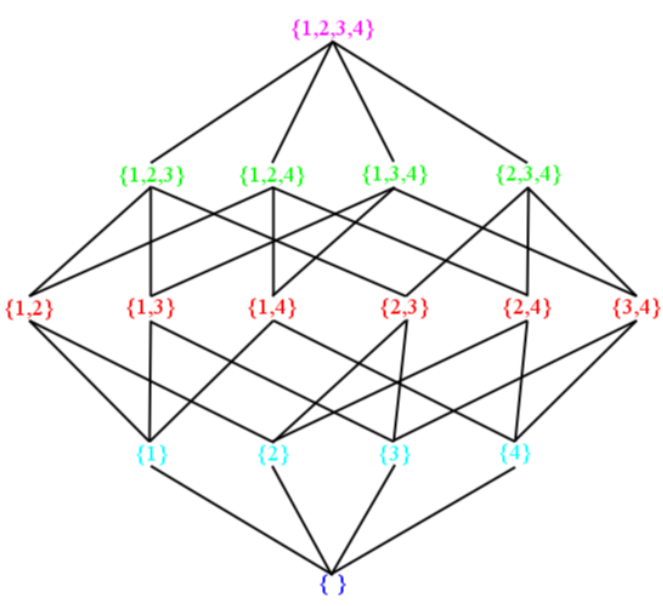
Figure 2. 𝐿(𝒫({1,2,3,4})) . Figure 2. L ( P